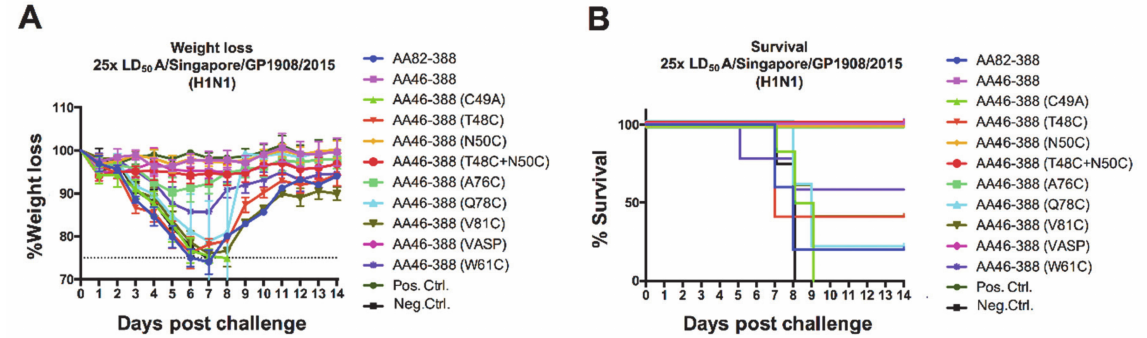
Figure 3. Weight loss kinetics and survival monitoring of vaccinated mice following H1N1 challenge. Mice were vac- cinated with each of the NA constructs ( n = 5 per group) in a prime-boost regimen. Here, 3 ug of the respective re- combinant protein adjuvanted with AddaVax was administered. As negative and positive controls, the Lassa virus glycoprotein and the tetrameric Mich15-VASP protein were administered. Mice were then challenged with 25 × LD 50 of A/Singapore/GP1908/2015 virus. Weight loss was monitored over 14 days post-challenge ( A ). Mice were euthanized when they lost 25% of their initial weight. Survival curves are shown ( B